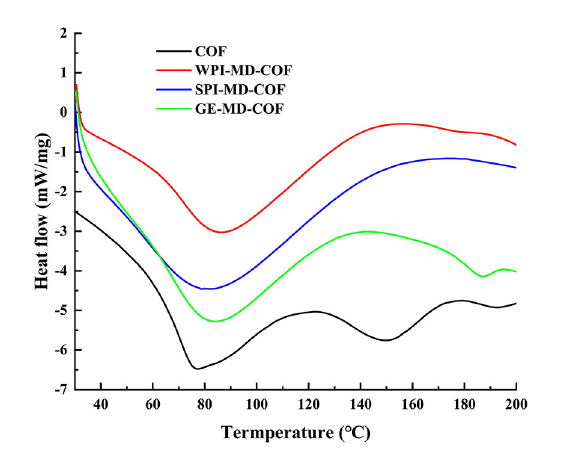
FIGURE2 Differential scanning calorimetry (DSC) spectra of COF microcapsule particles of COF, WPI-MD-COF, SPI-MD-COF, and GE-MD-COF.